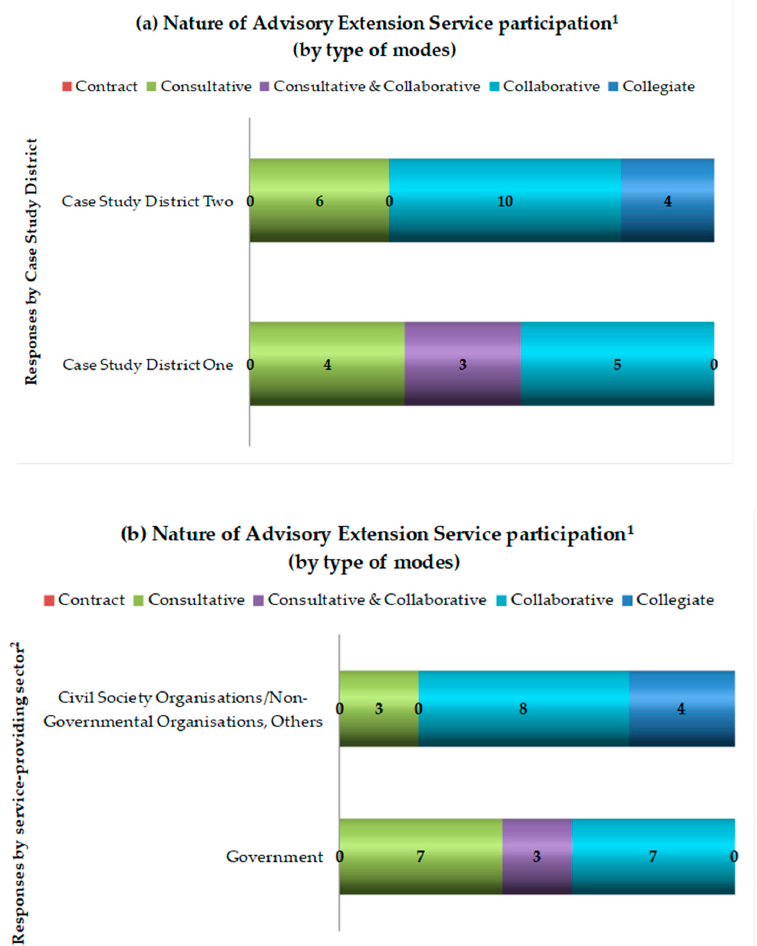
Figure 1. Mode of participation in Advisory Extension Services 1 as reported by smallholder farmers (Focus Group Discussion and Activity). ( a ) Responses categorised by Case Study District. ( b ) Response categorised by service-providing sector. N.B. 1 See Footnote no. 3. 2 Service-providing